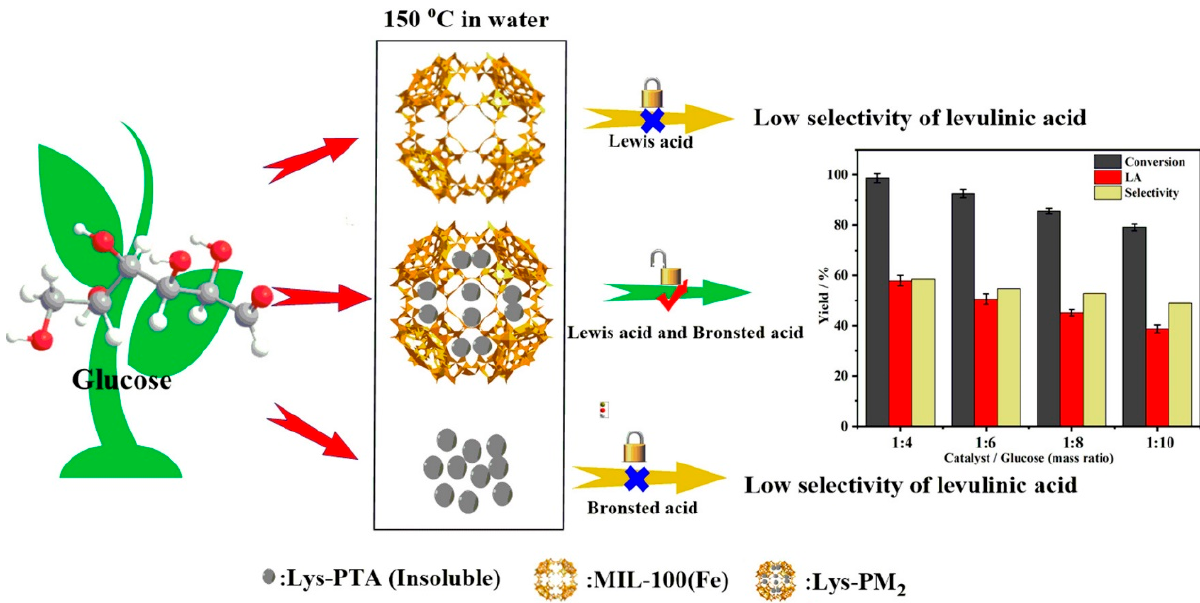
Figure 6. Production of furfural from glucose in the presence of the Lys-PM 2 catalyst [121]. Reproduced with permission from Ref. [121]. Table 4. Production of LA from lignocellulose and biomass over different heterogeneous catalysts. Reaction Conversion No. Substrate Catalysts Solvent Conditions No.